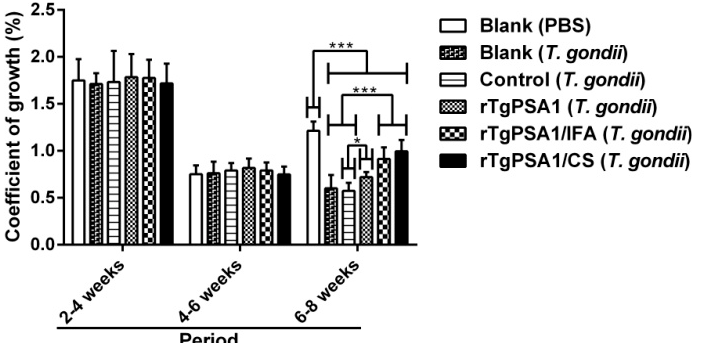
Figure 11. Coefficient of growth in chickens. Ten chickens were weighed at different sampling times. Results were assessed by one-way ANOVA followed by Dunnett’s test, and values are shown as mean ± SD (n = 10). Values between rTgPSA1/IFA and rTgPSA1/CS groups were compared with the independent t -test. * p < 0.05 and *** p < 0.001 compared with blank or control group.